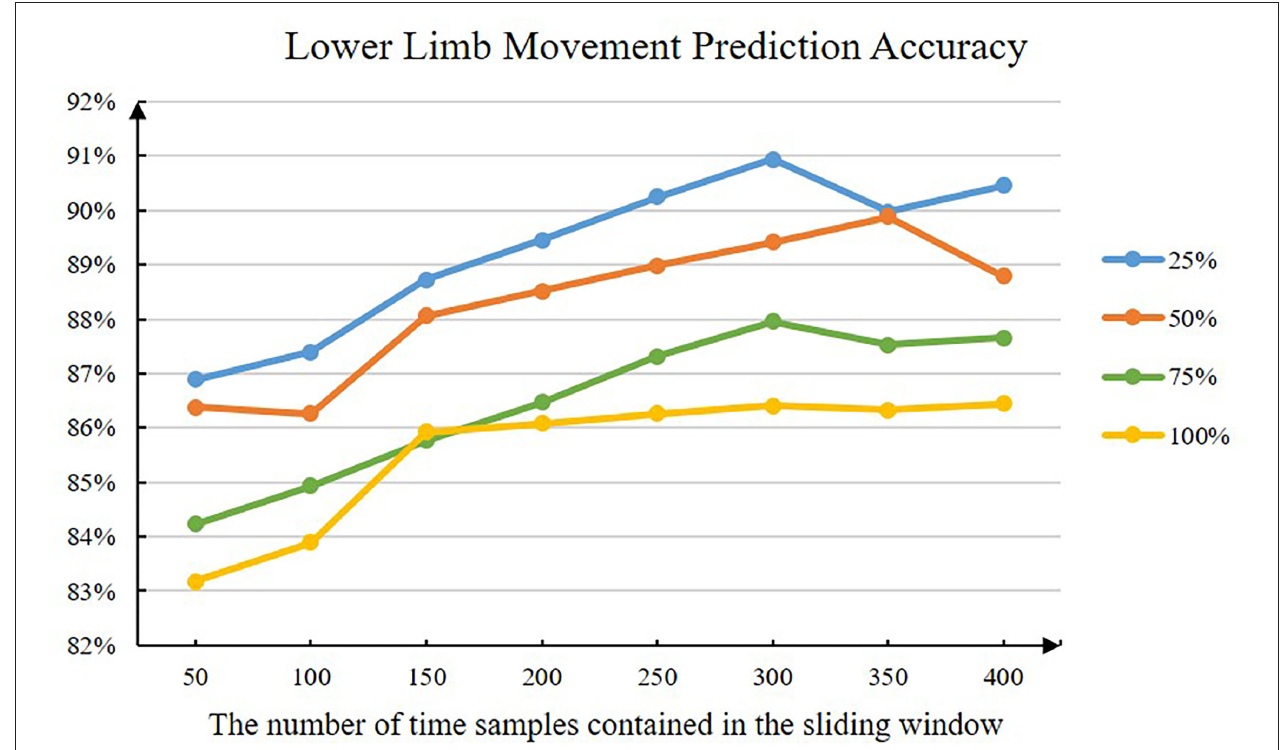
FIGURE 4 | The accuracy of the lower limb movement prediction method when the sliding window parameter has changed. The abscissa represents the number of time samples contained in different sliding windows. The lines of different colors represent different moving step sizes (e.g., 25% means that the moving step size is 25% of the sliding window